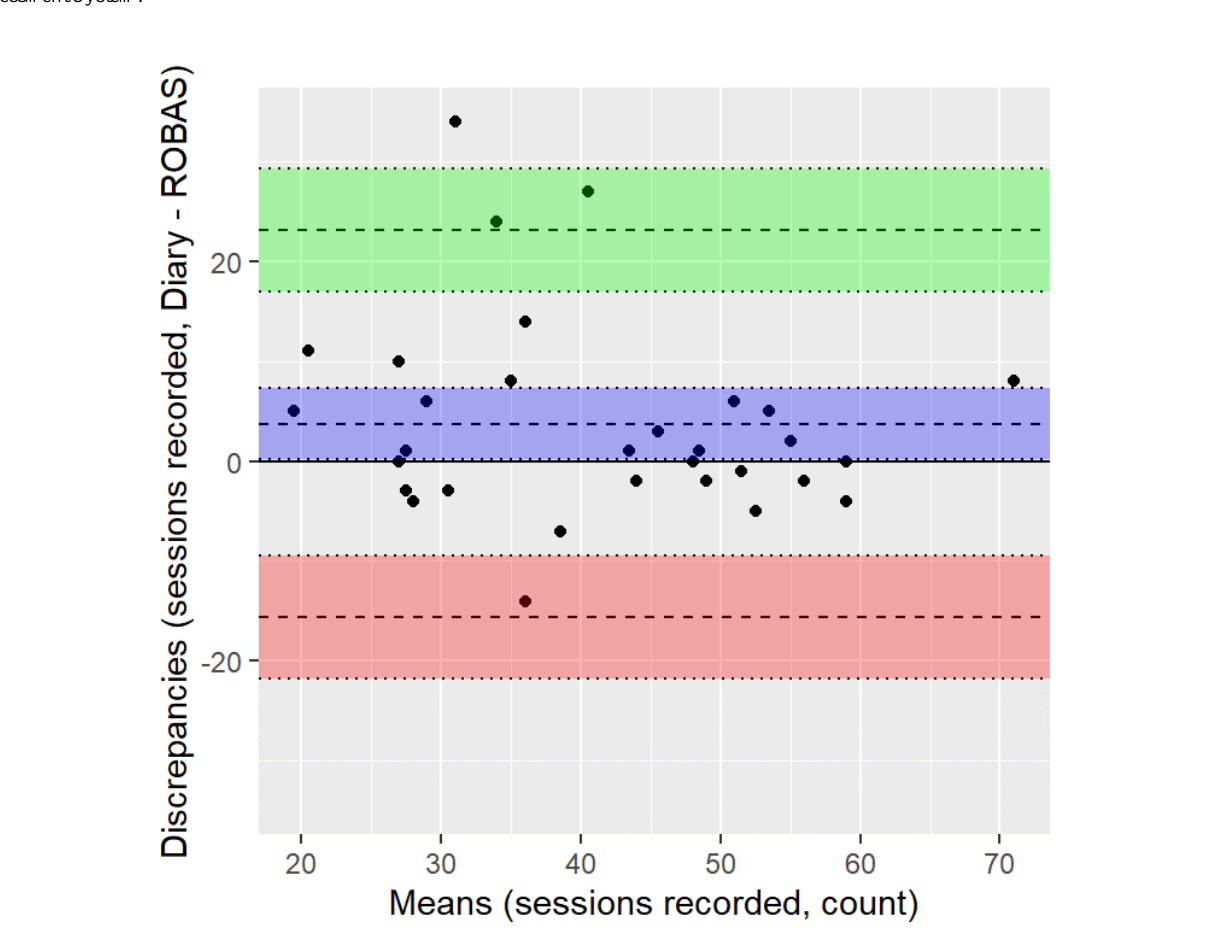
Figure 3. Bland-Altman plot of the number of sessions recorded, as measured by brushing diary versus ROBAS system. ROBAS: Remote Oral Behaviors Assessment